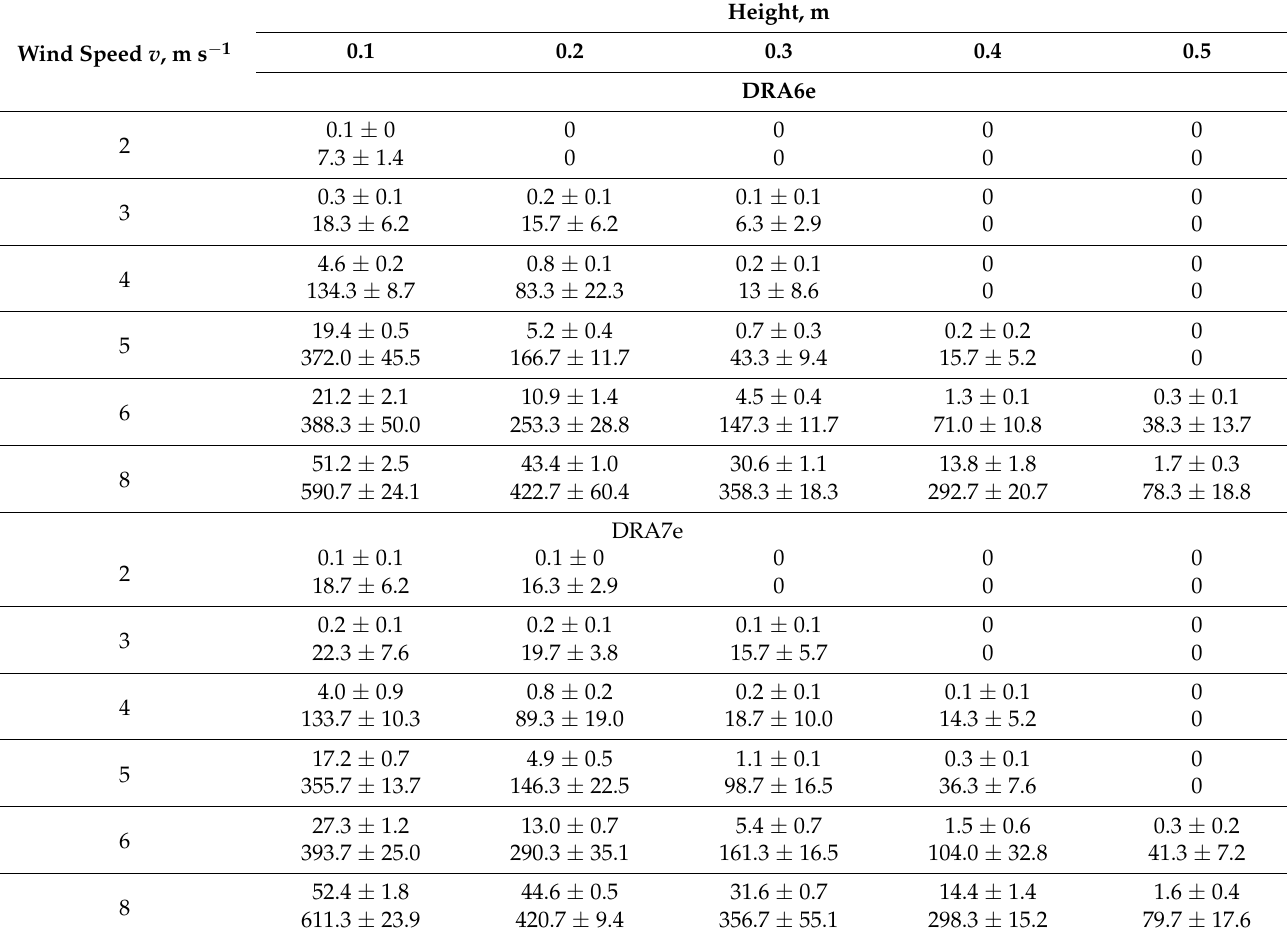
Table 3. Water-sensitive paper coverage (upper line, %) and number of droplets (lower line) when spraying with the standard flat spray nozzle in the wind tunnel, 4 m from the nozzle (0.1–0.5 m height measured vertically in direction of the y -axis from the corrugated tin, Figure